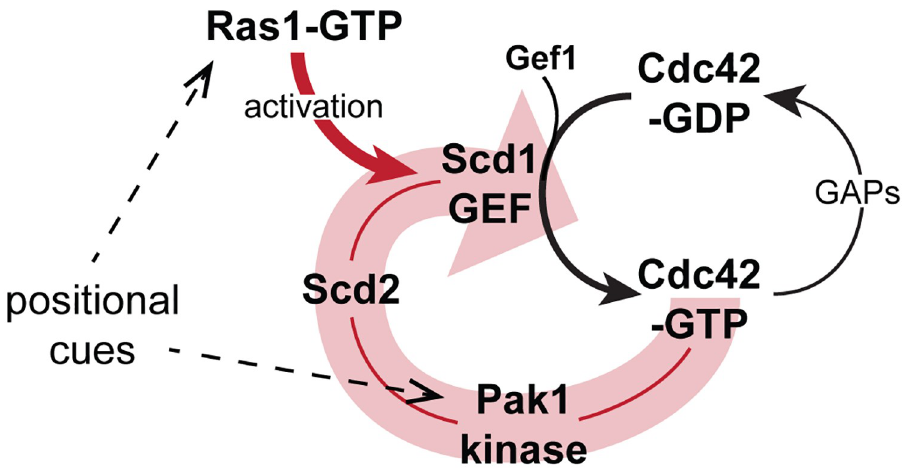
Fig 10. Model of scaffold-mediated positive-feedback regulation of Cdc42 activity gated by Ras1 GTPase. The schematics shows the Scd2 scaffold-mediated positive feedback on Cdc42 activation (wide, pale red arrow) and input by Ras1-GTP. By promoting Scd1 activity, Ras1-GTP amplifies the positive feedback. Positional cues on Cdc42 are transmitted through both Ras1-GTP and Pak1. GAP, GTPase activating protein; GEF, guanine nucleotide exchange